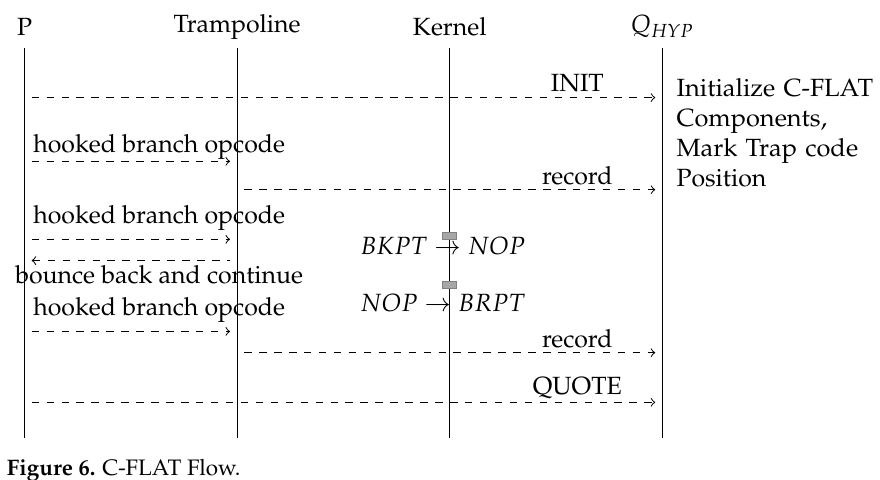
Figure 6. C-FLAT